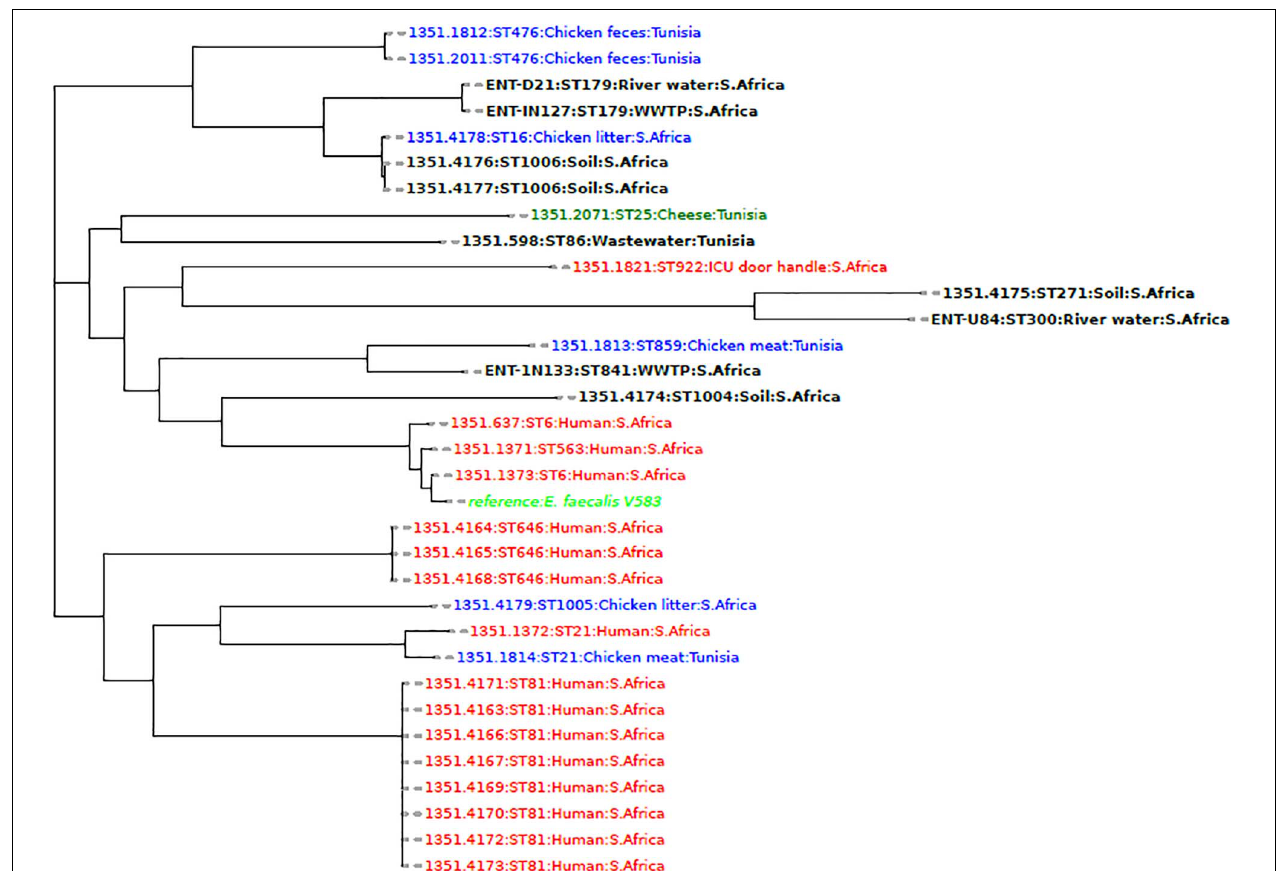
FIGURE 1 | A phylogenomic tree showing the relationship of E. faecalis isolates from this study with African isolates from humans (red), animals (blue), and the environment (black) obtained from the PATRIC database